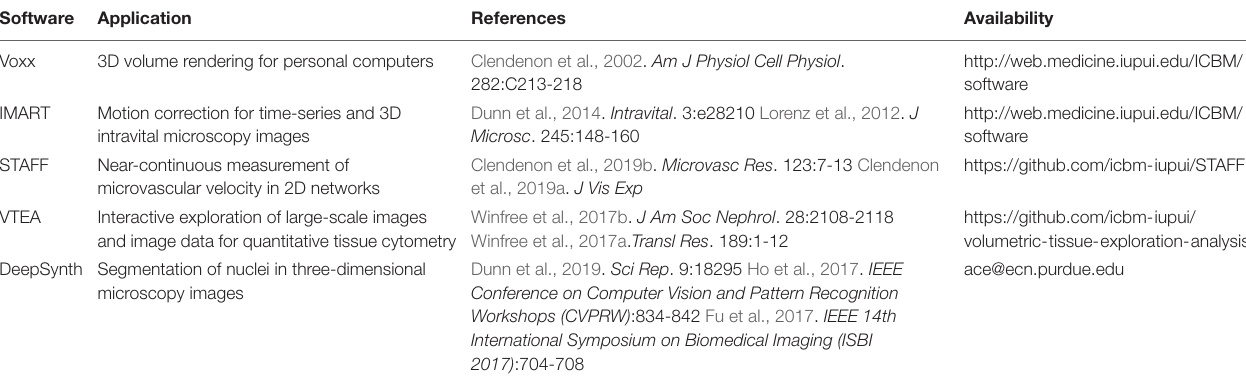
TABLE 1 | Software developed by the Indiana O’Brien